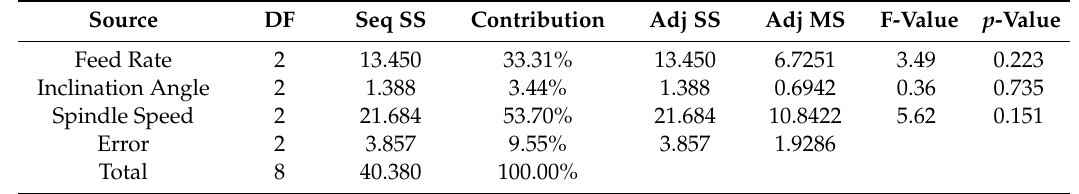
Table 12. Results of the ANOVA for Temperature.